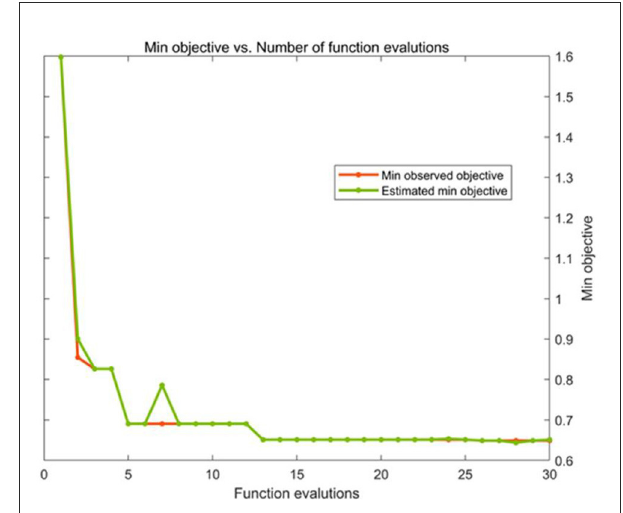
Model parameter optimization